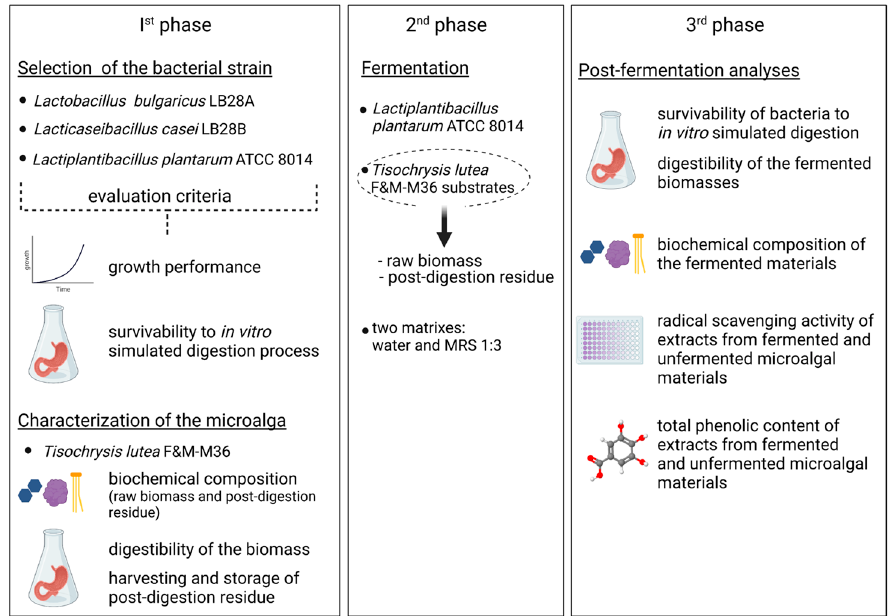
Figure 1. Outline of the experimental design of the work. More specifically, T. lutea F&M-M36 raw biomass was characterized for its biochemical profile and for in vitro digestibility. The dried digested residue was stored for further use. and for resistance to in vitro simulated digestion, expressed as cell survivability.